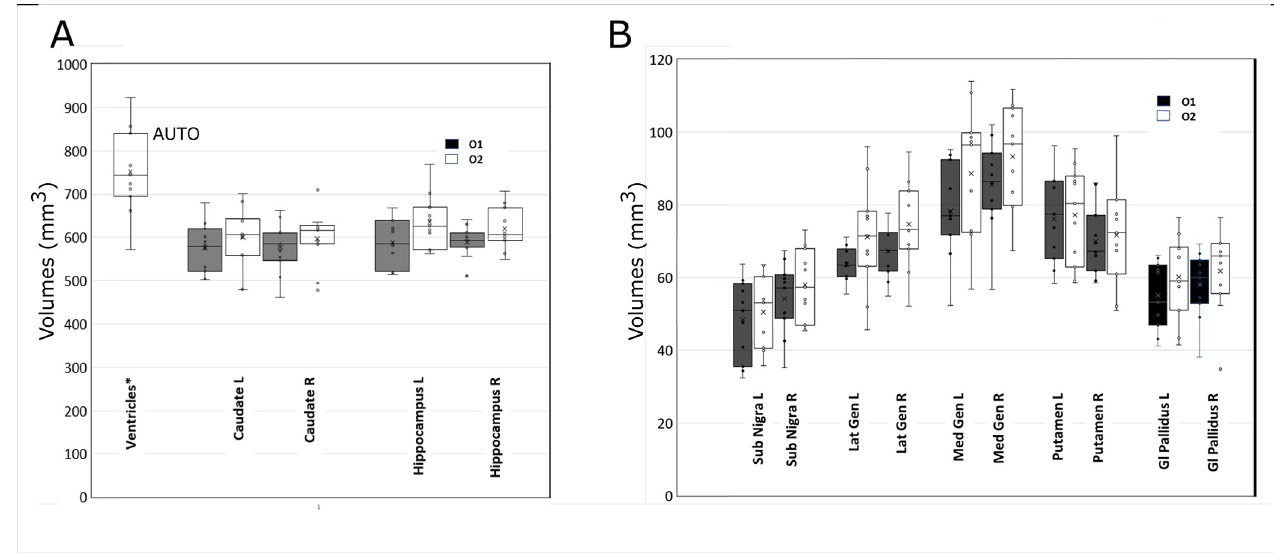
Fig 3. Data distribution of the segmented structures. Whisker plot for the distribution of the segmented volumes from the two operators O1 (black) and O2 (white). A) The set Ventricles, Caudate, and Hippocampus. Ventricles have been automatically segmented. No statistical differences have been observed. B) The set Substantia Nigra, Lateral and Medial Geniculate, Putamen and Globus Pallidus. In this set, no statistical difference was observed.